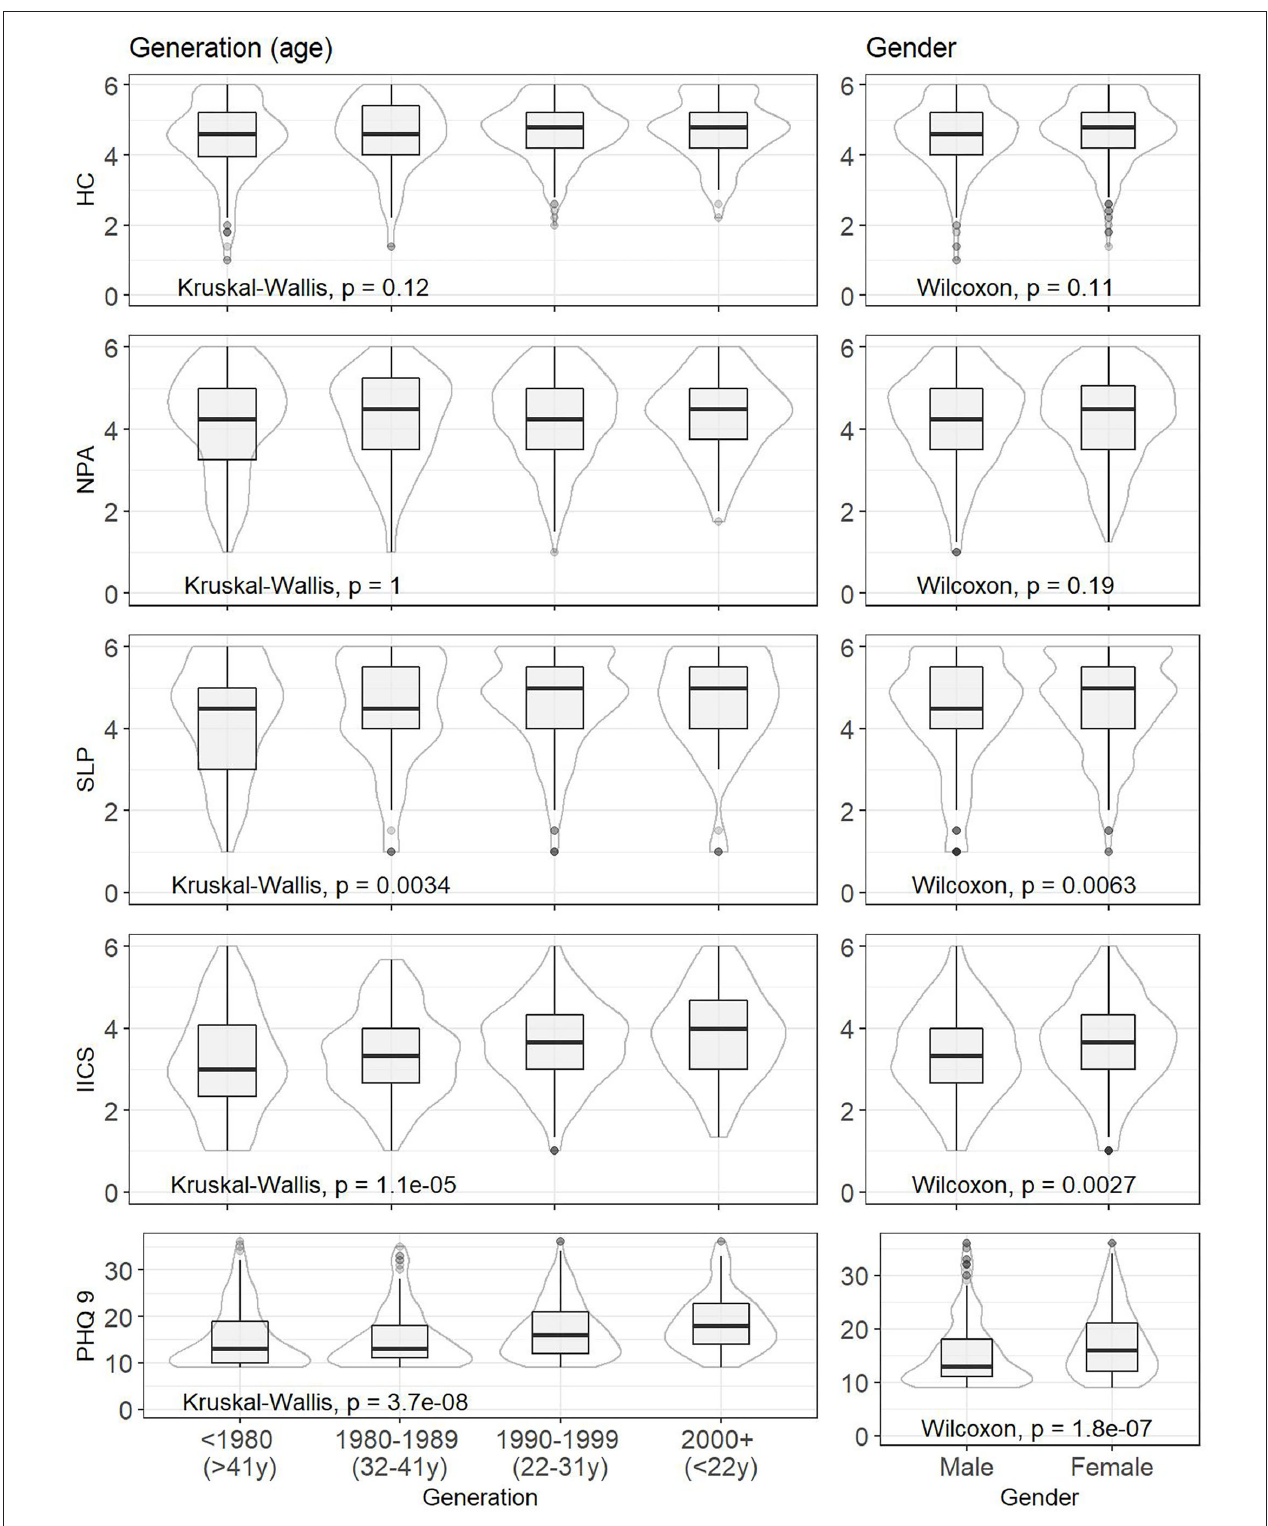
FIGURE 2 | Selected statistical characteristics of indicators and results of difference tests—classification by age and gender.